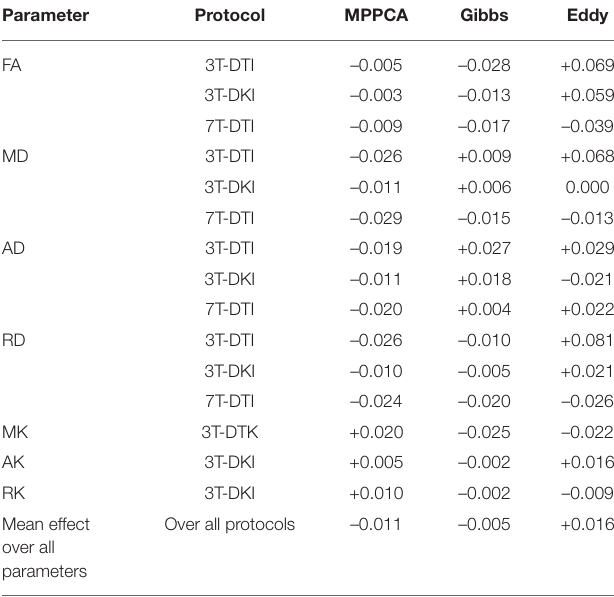
TABLE 2 | The impact of each processing step (Marchenko-Pastur principal component analysis (MPPCA), Gibbs, and Eddy) on the effect size.